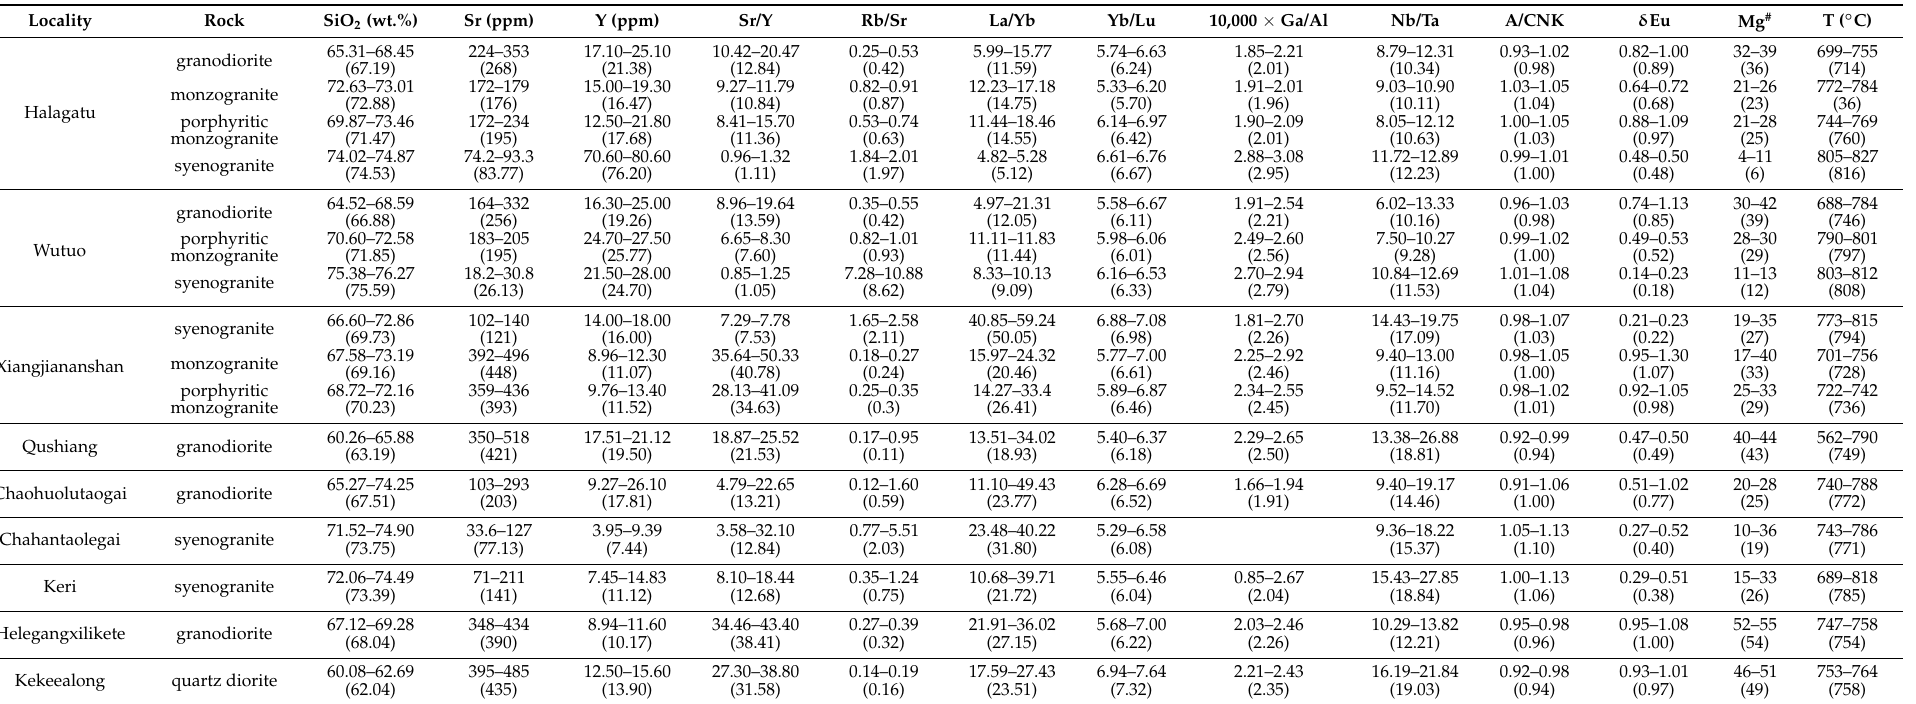
Table 2. Petrogeochemical characteristics of the Indosinian granite in eastern region of